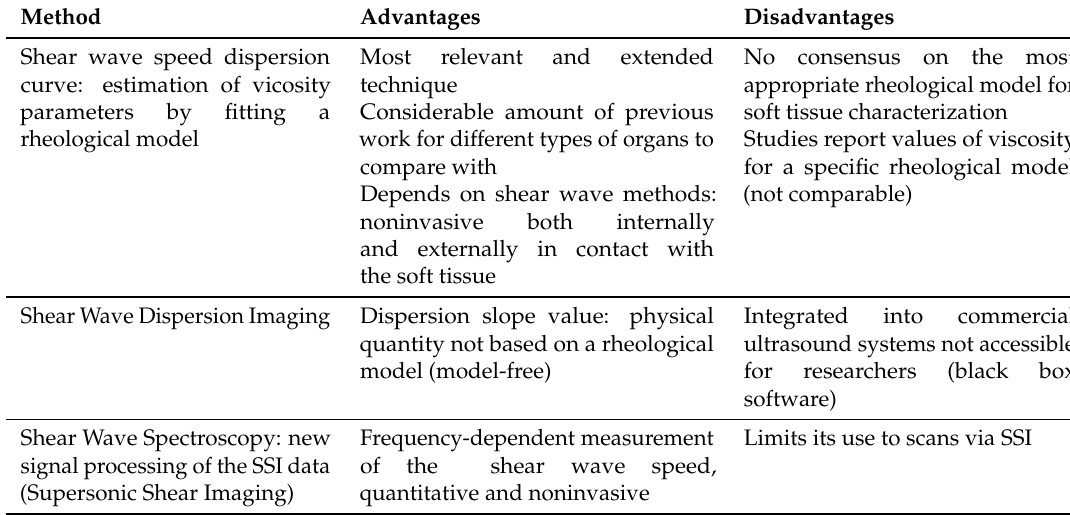
Table 2. Comparison of the current methods that have been able to successfully estimate viscosity parameters using ultrasound